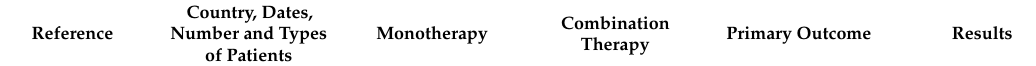
Table 2. Open label randomized controlled trials comparing polymyxin combination antibiotic therapy